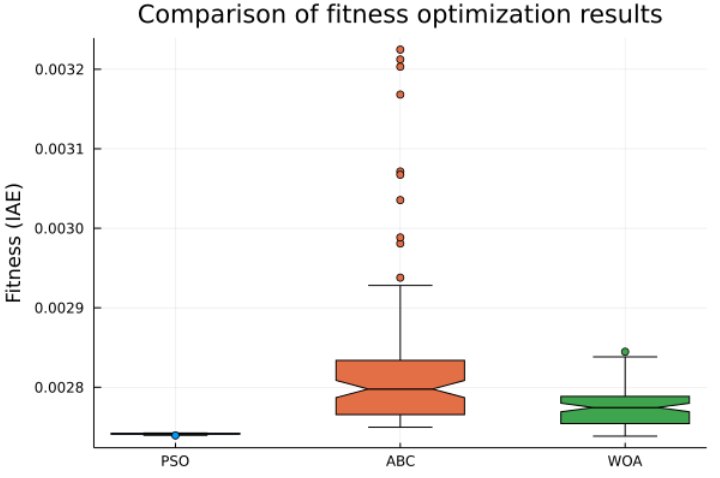
Figure 13. Boxplot of the fitness considering 100 independent experiments.